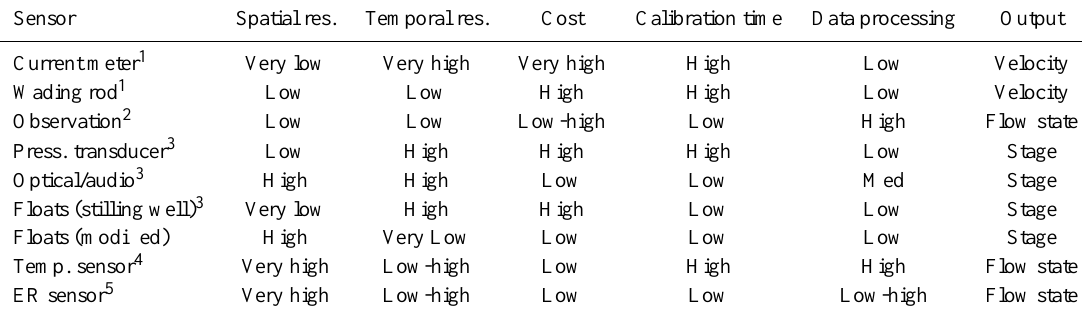
Table 2. Comparison of monitoring techniques Sensor Spatial res. Temporal res. Cost Current meter 1 Very low Very high Very high High